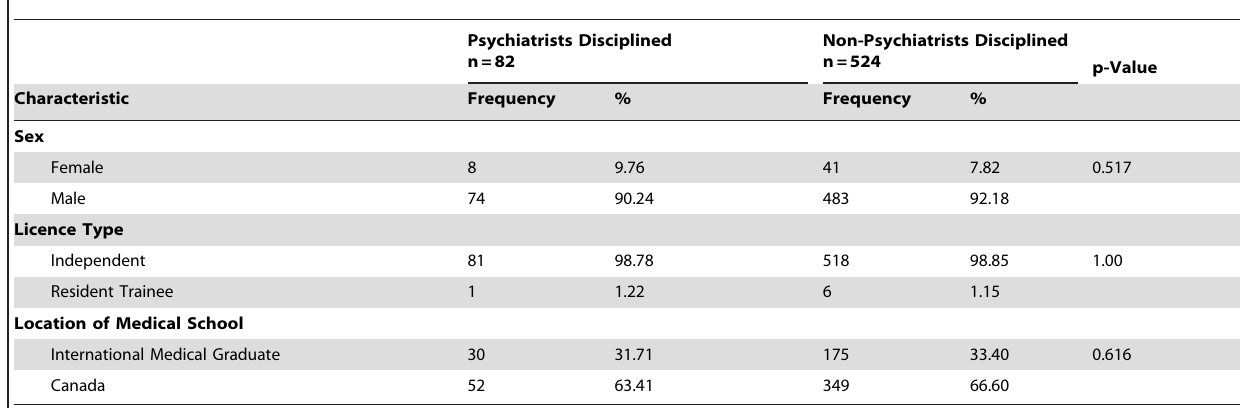
Table 1. The characteristics of disciplined psychiatrists and other physicians in Canada for the ten years from 2000 through